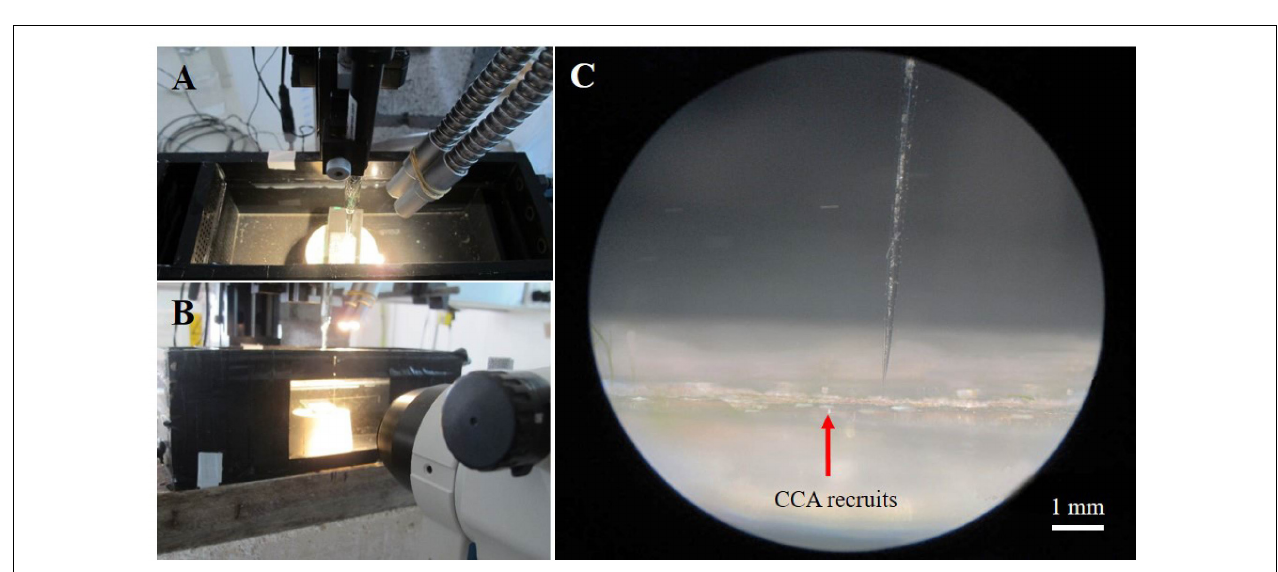
FIGURE 1 | Setup for O 2 microsensor measurements on crustose coralline algae. General overview of the set-up showing a flow-chamber with a mounted CCA sample (A,B) , with an O 2 microsensor mounted in a manual micromanipulator, illumination via a fiber-optic halogen lamp, and observation of the sample via a dissection microscope (B) . (C) Close up image (via the dissection microscope) of an O 2 microsensor performing O 2 measurements on CCA recruits (pink